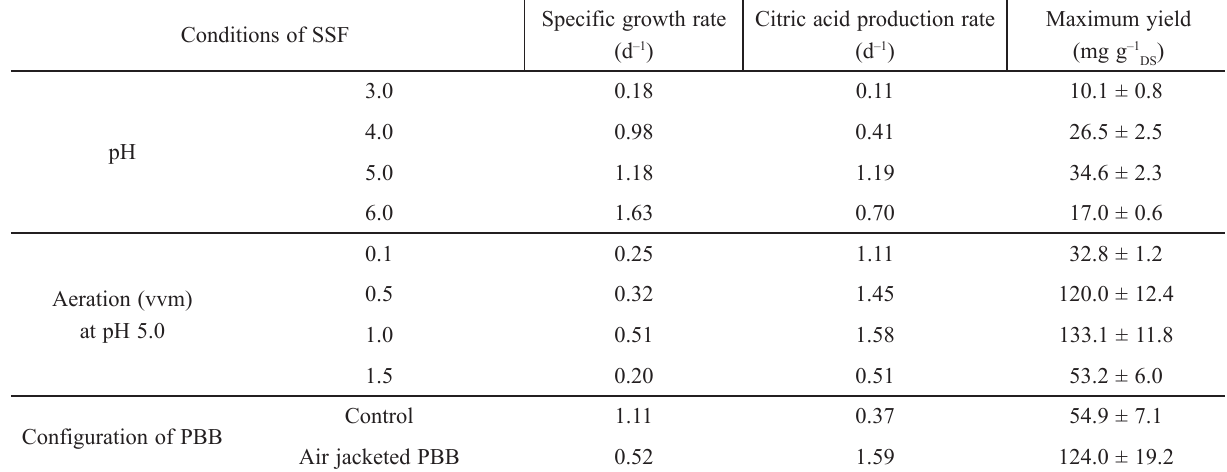
Table 1 – Parameters of growth and citric acid production under solid-state fermentation of banana peel by A. niger in different